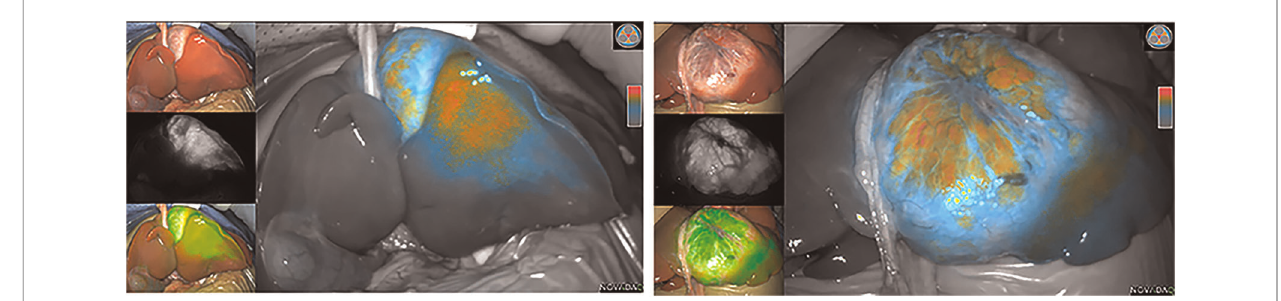
FIGURE 2 | Intraoperative (ICG) fl uorescence imaging shows remarkable contrast between tumor ( fl uorescence color) and normal liver parenchymal.